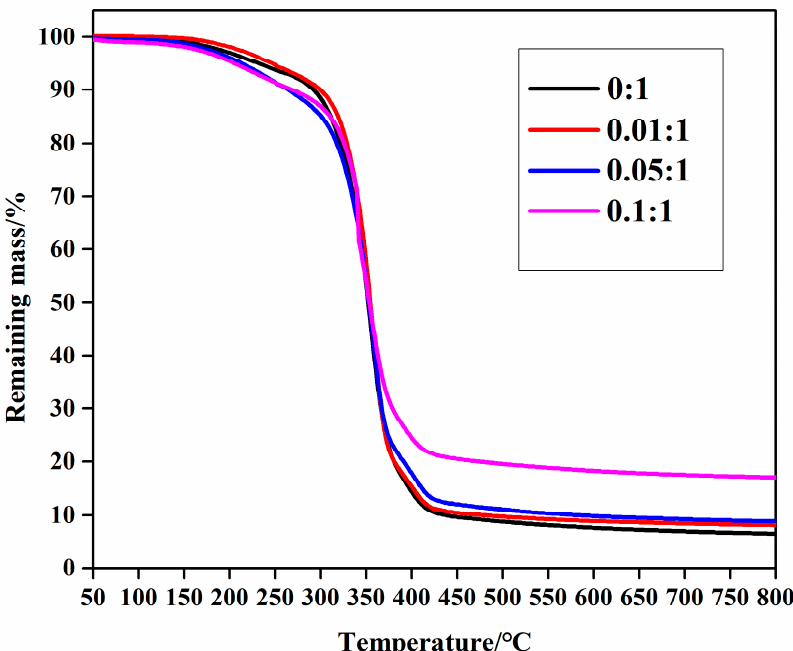
Figure 5. Thermal gravimetric analysis (TGA) curves (50–800 °C) of drug-loaded MPEG-PDLLA/c- MWCNT nanocomposites prepared from different amounts of c-MWCNTs added to the MPEG- PDLLA/c-MWCNT mixed solutions.